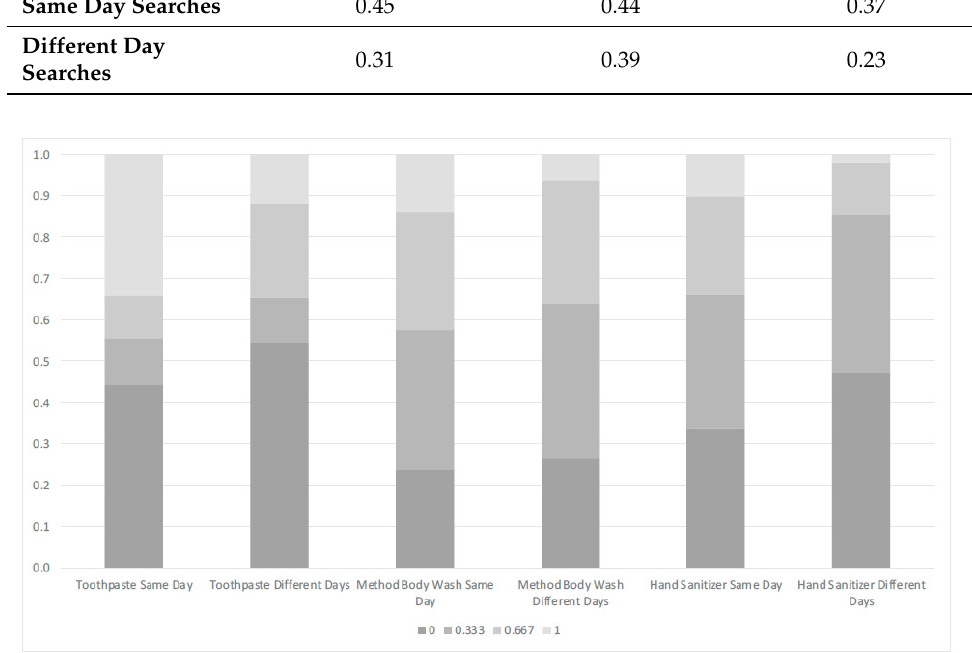
Figure 4. Comparison between the distribution of the overlap coefficient for searches undertaken on the same day and searches undertaken on different days, for each of the three products. Each bar shows the percentages of participant pairs in the specified category (same day/different days) having an overlap coefficient of 0, 0.33, 0.66, and 1. Same-day pairs, n = 5749. Different-day pairs, n = 46901. Table 5. Average overlap coefficient between the search results of each product for pairs of searches undertaken on the same day and pairs of searches undertaken on different days.